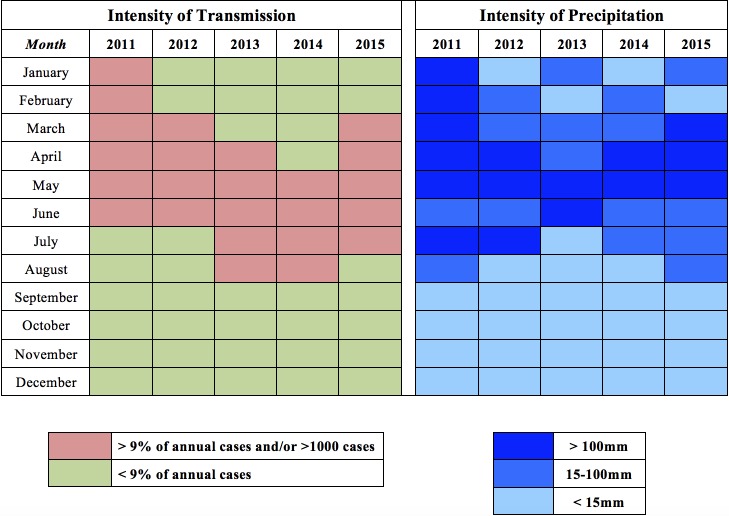
Classification of months according to the intensity of dengue transmission and of precipitation, Fortaleza, 2011–15.Months with high intensity of transmission (more than 9% of total annual dengue cases or more than 1,000 total cases citywide) are represented in pink, and those with low intensity in green. Months with high intensity of rainfall (more than 100 millimeters), medium (15-100mm), and low (less than 15mm) are represented in shades of blue.